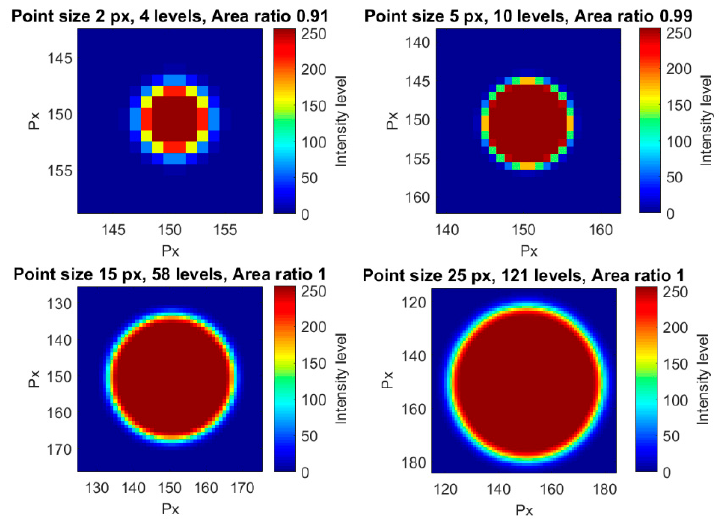
Figure 6. Four different examples of points with different point sizes and an area ratio of 1.